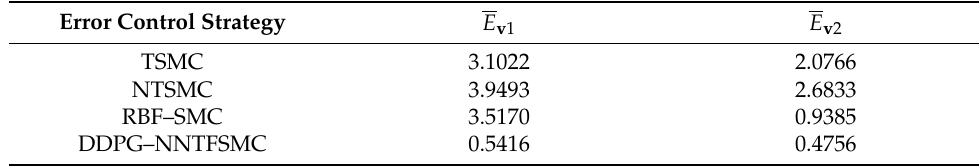
Table 5. The average speed errors under control input signals of the control